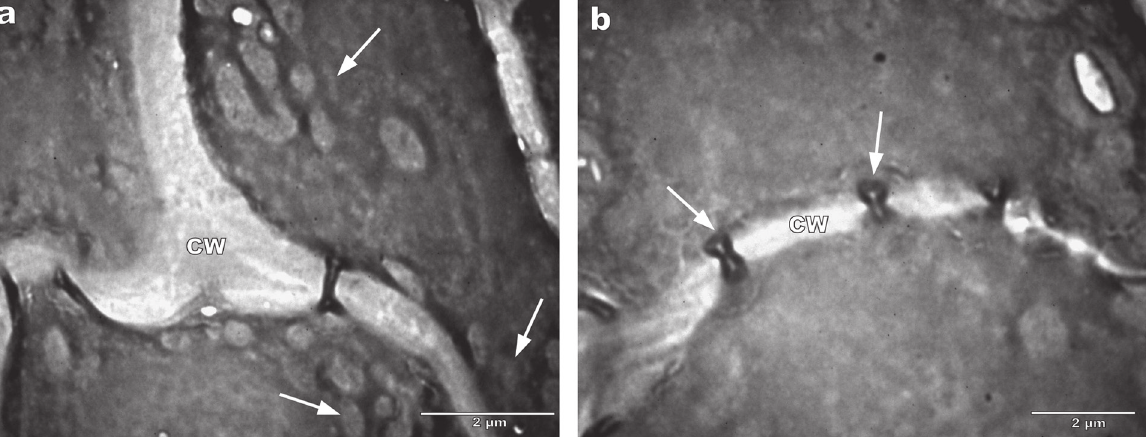
Figure 7 - Transmission electron micrographs of the callus Type 2. A) Thick cell wall with few gaps between the cell. Mitochondria (arrows). B) Plasmodesmata (arrows) and cell wall